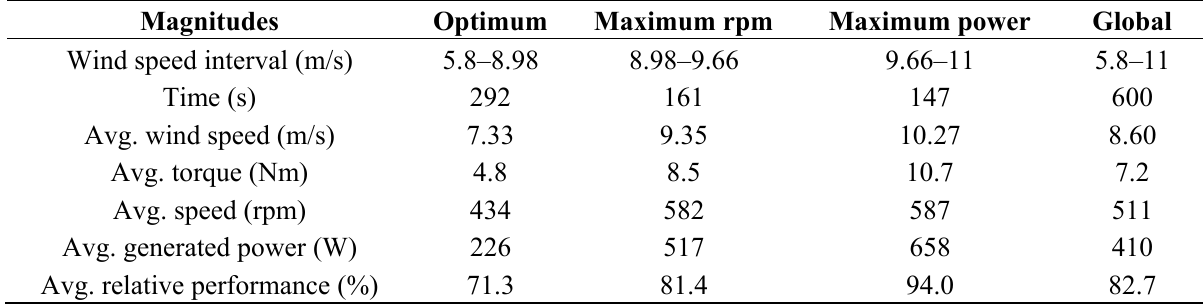
Table 3. Second test averaged values for the three operational modes, and